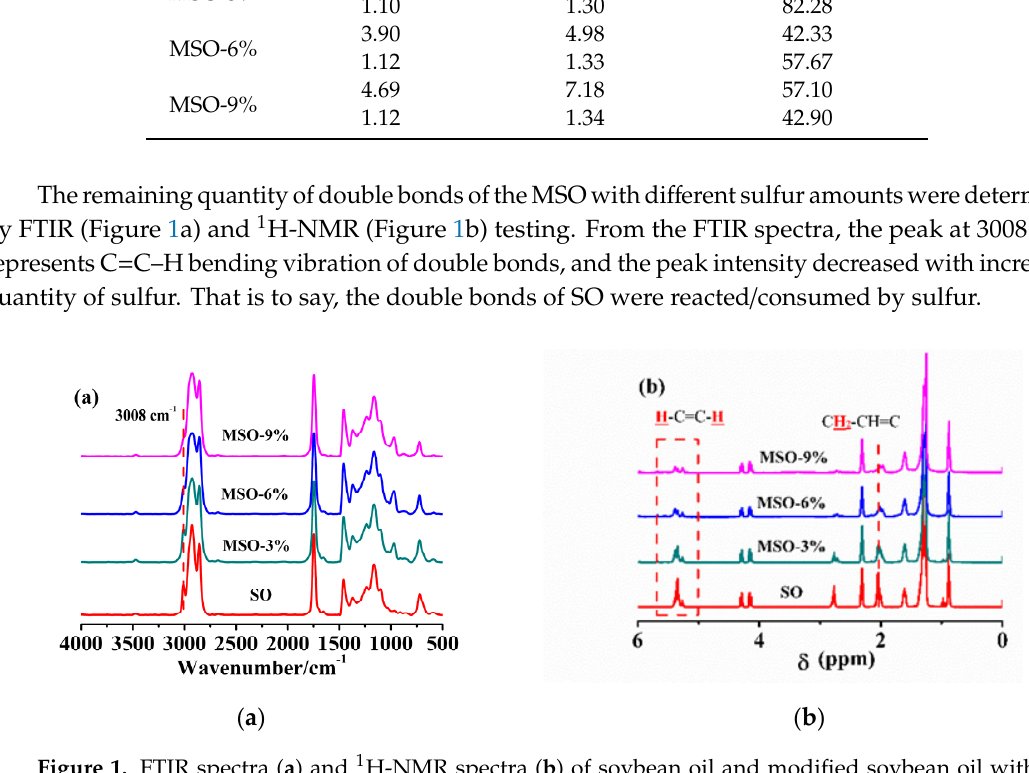
Figure 1. FTIR spectra ( a ) and 1 H-NMR spectra ( b ) of soybean oil and modified soybean oil with different amounts of reagents.